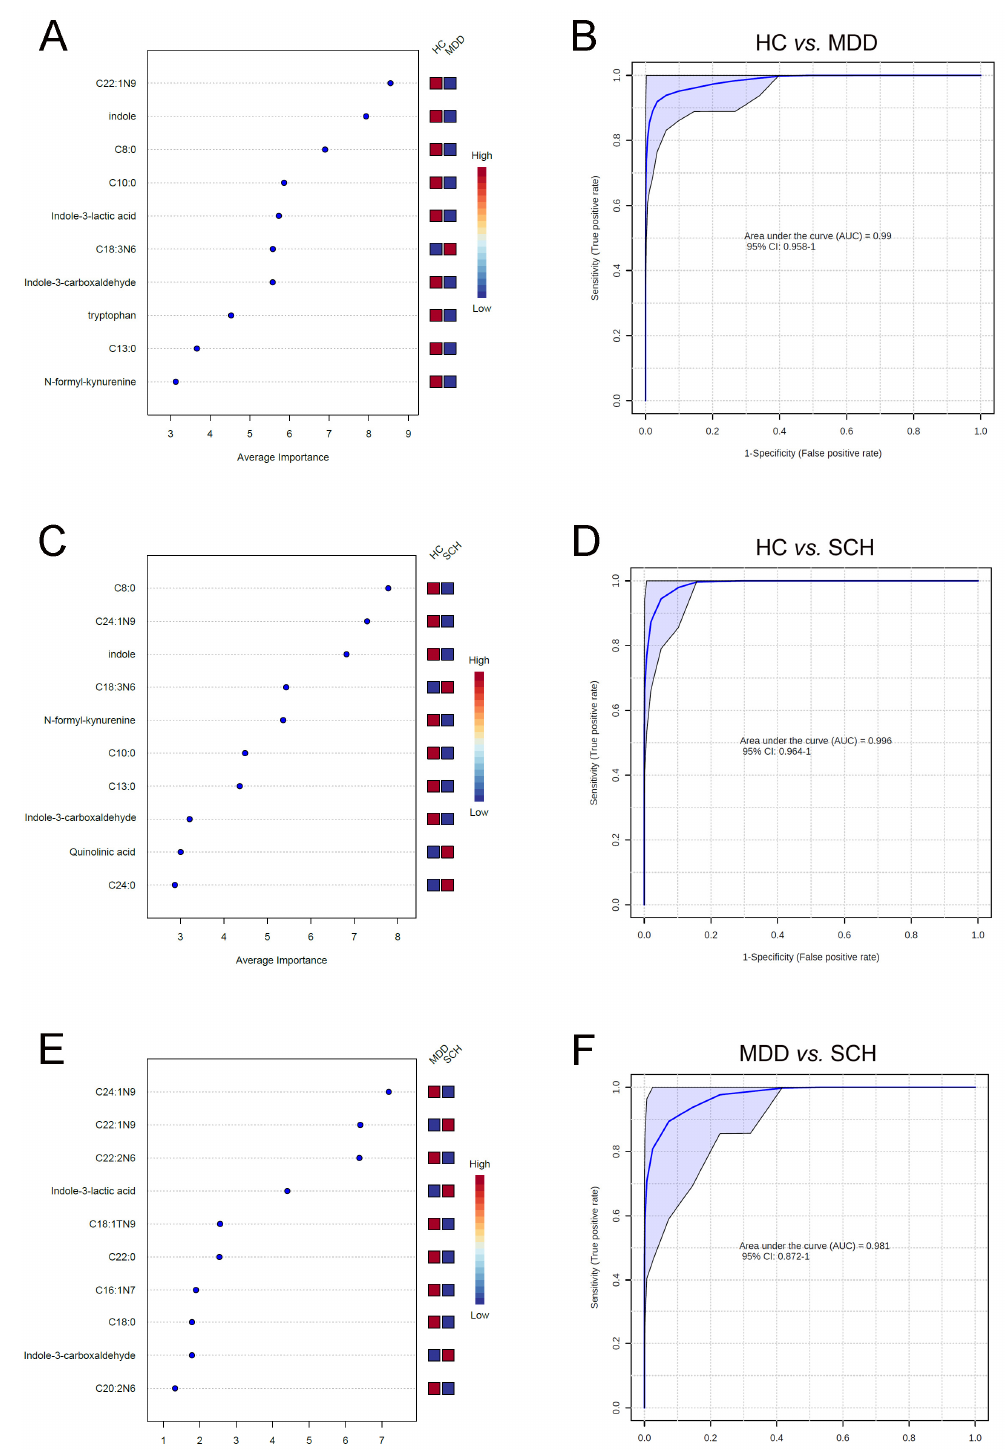
Figure 3. Metabolomic markers and AUC value of ROC analysis for discriminating between MDD, SCH, and HC. Top 10 differential markers identified from random forest classifiers based on the combination of Trp and fatty acids and AUC value of ROC analysis to detect MDD from HC ( A , B ), SCH from HC ( C , D ), and MDD from SCH ( E , F ). Abbreviations: C8:0, caprylic acid; C10:0, capric acid; C13:0, tritridecanoin; C18:0, stearic acid; C22:0, behenic acid; C24:0, lignoceric acid; C16:1N7, palmitoleic acid; C22:1N9, erucic acid; C24:1N9, nervonic acid; C18:1TN9, elaidic acid; C18:3N6, gamma-linolenic acid; C22:2N6, docosadienoic acid; C20:2N6, eicosatrienoic